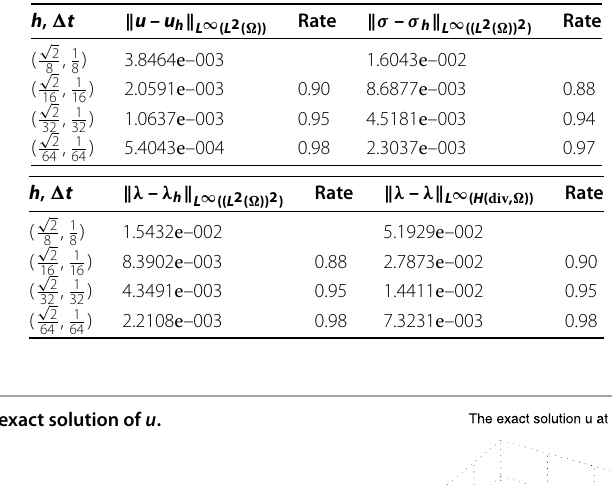
Table 1 Error estimates and convergence rates